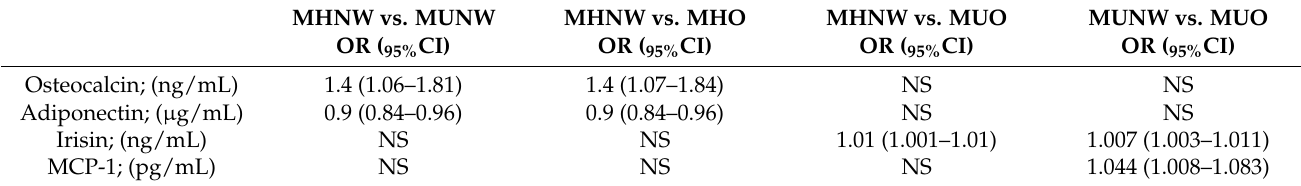
Table 3. Multiple logistic regression model adjusted by menopausal status according to the different phenotypes. MHNW vs. MUNW MHNW vs. MHO MHNW vs. MUO MUNW vs. OR ( 95% CI) OR ( 95% CI) OR ( 95% CI)